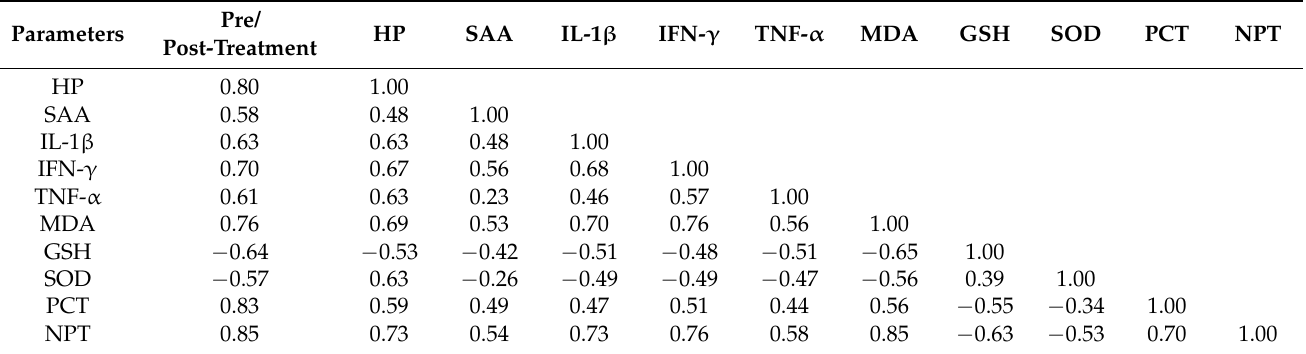
Table 2. Correlation matrix among acute-phase proteins (HP, Haptoglobin; SAA, serum amyloid A), proinflammatory cytokines (IL1- β , Interleukin one beta; IFN- γ , Interferon gamma; TNF- α , tumor necrosis factor alpha), oxidative stress markers (MDA, malondialdehyde; GSH, reduced glutathione; SOD, super oxide dismutase), procalcitonin (PCT), and neopterin (NPT) in the serum of diarrheic feedlot calves naturally infected with C. parvum pre- and 7 days